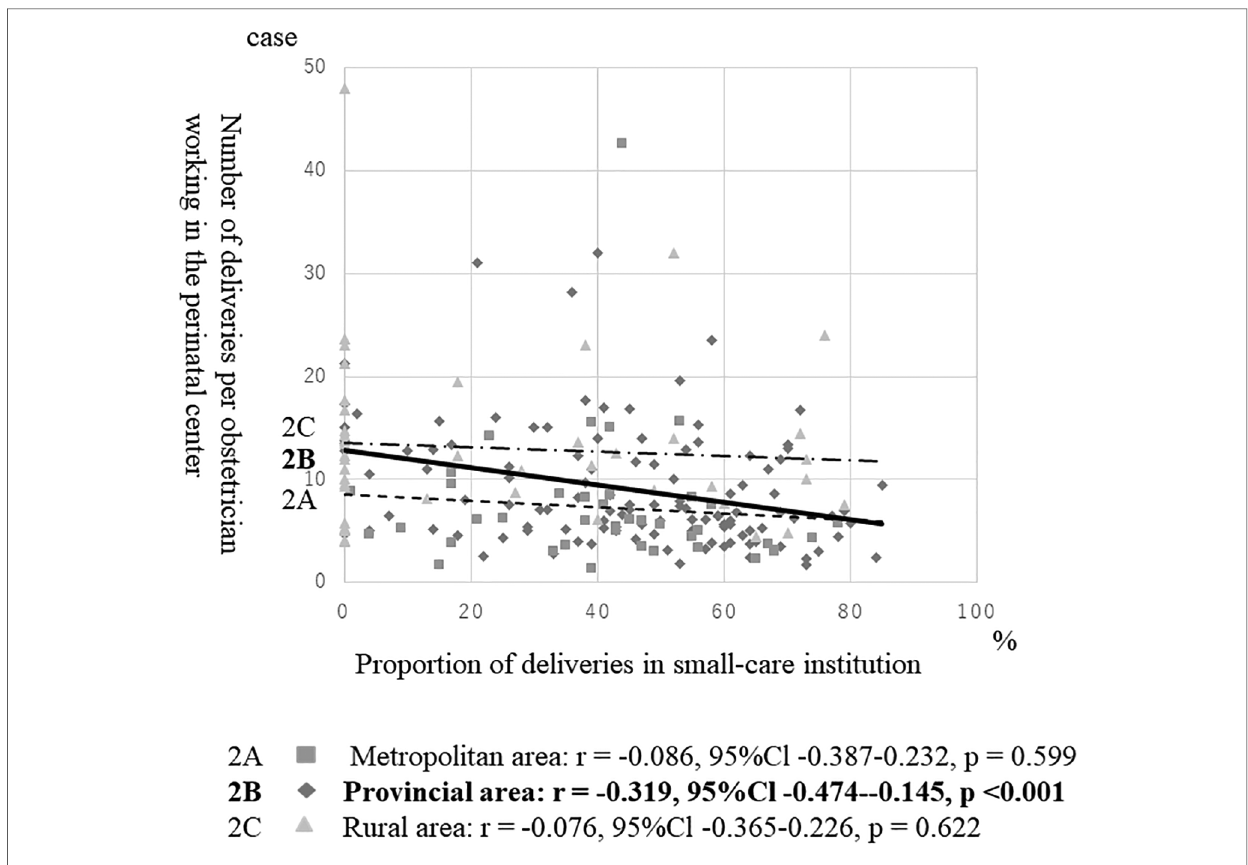
FIGURE 2 Correlation between the proportion of deliveries in clinics with beds and the number of deliveries per obstetrician working in the perinatal center. CI, con fi dence interval. Note: The analysis excludes perinatal care areas without perinatal